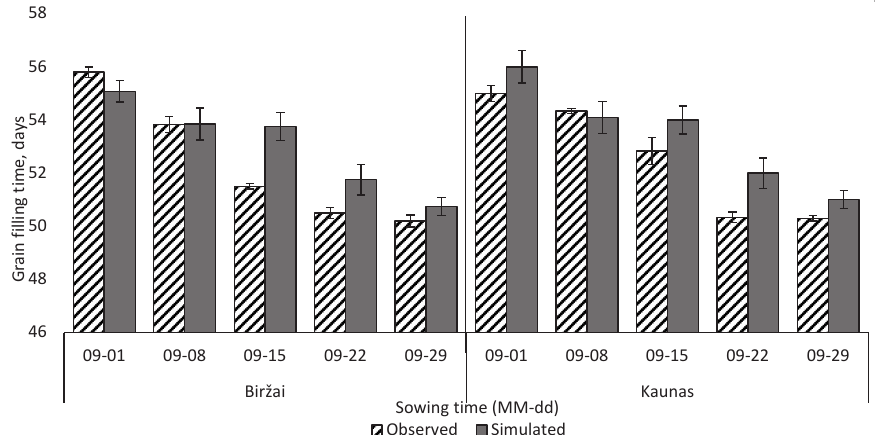
Fig. 4. Simulated and observed winter wheat grain filling phenological stage duration (days) at different sowing